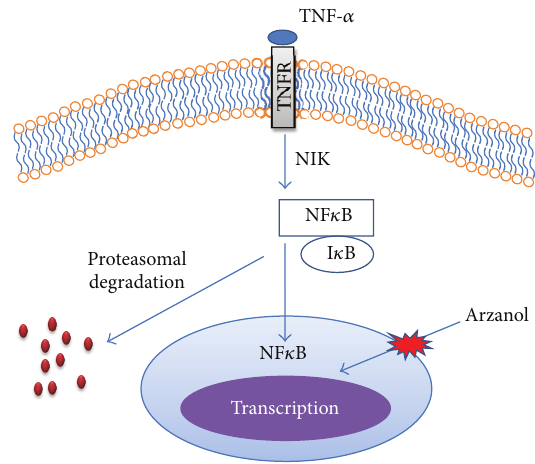
Figure 7: TNF- 𝛼 mediated NF 𝜅 B signal transduction pathway. TNF- 𝛼 bind to TNFR (TNF- 𝛼 receptor) lead to activation of NF- 𝜅 Binducingkinase(NIK)whichphosphorylatesandactivatesNF 𝜅 B and I 𝜅 B (inhibitors of NF 𝜅 B) complex. IKK then phosphorylates I 𝜅 B, which leads to its ubiquitination and degradation by the proteasome. NF- 𝜅 B then enters the nucleus and acts on target genes. Arzanol inhibit this NF 𝜅 B activation involved in signal transduction pathway. (Adapted and modified from Appendino et al.